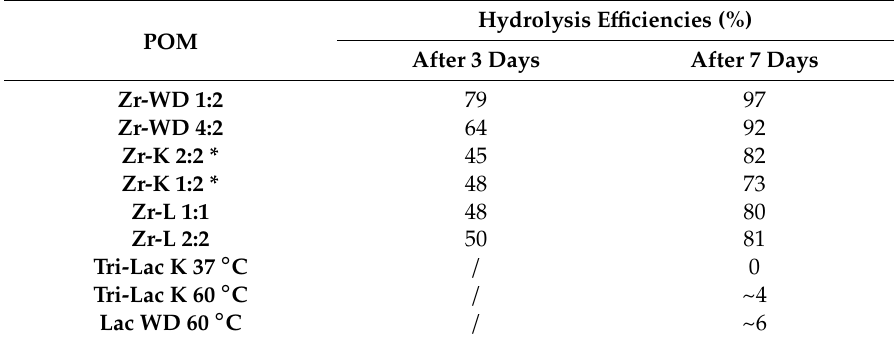
Figure 3. SDS-Page gel featuring intact transferrin (lane 1), transferrin incubated in phosphate buffer (lanes 2–3), and transferrin incubated in buffer solutions containing control samples. The samples were incubated for 7 days.